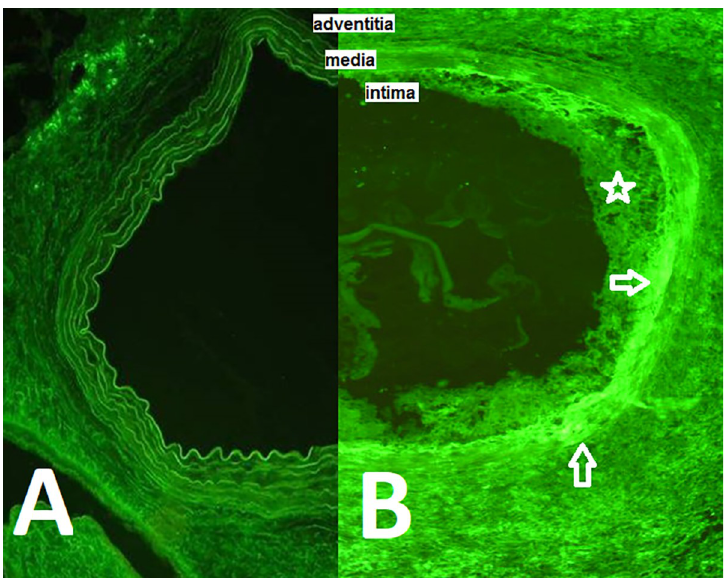
Fig 2. Representative histological features of cryopreserved (A) and cold-stored aortal allografts (B) on day 30 posttransplant. Immunofluorescent staining for immunoglobulins G with a fluorescein isothiocyanate- conjugated antibody. The rats aortal allografts processed in accordance with cryoconservation/slow thawing protocol used in the Czech national “Cryopreserved vascular grafts program” (A) showed clear differentiation of all three basic anatomical layers with no intimal hyperplasia and no IgG deposition in the medial layer. The rats aortal allografts processed in accordance with clinical cold-storage protocol (B) showed significant signs of rejection in all three wall layer represented by intimal hyperplasia (white star), destruction of medial layer with massive deposition of IgG (white arrows) and massive adventitial infiltration with immunocompetent cells of host origin. Original magnification x 100. adventitia–Tunica adventitia media–Tunica media intima–Tunica media.